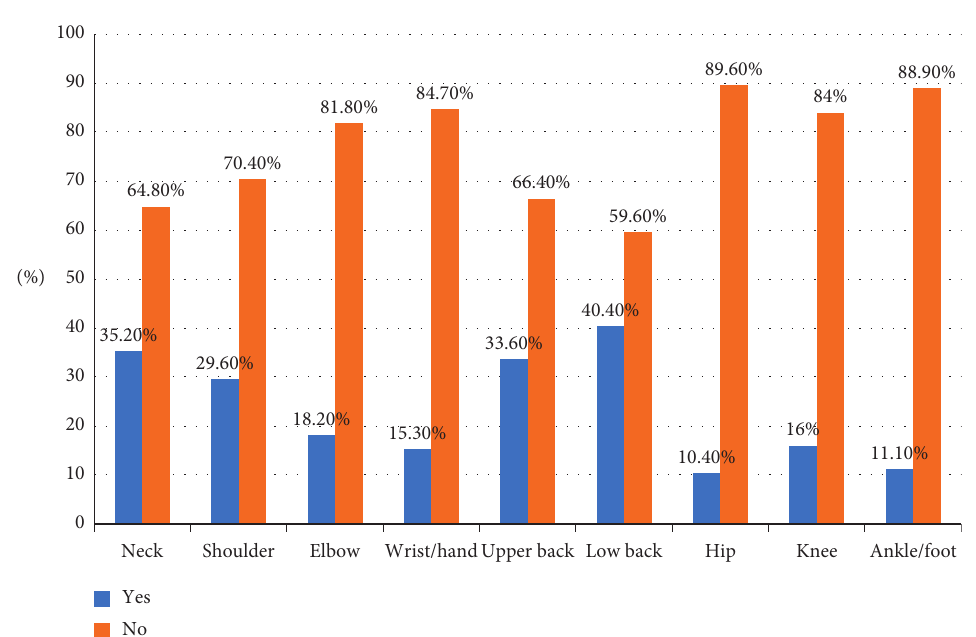
Figure 1: Prevalence of WMSDs distribution in body parts among bankers working in Mekelle city, Tigray, Ethiopia, May 2018 ( n �